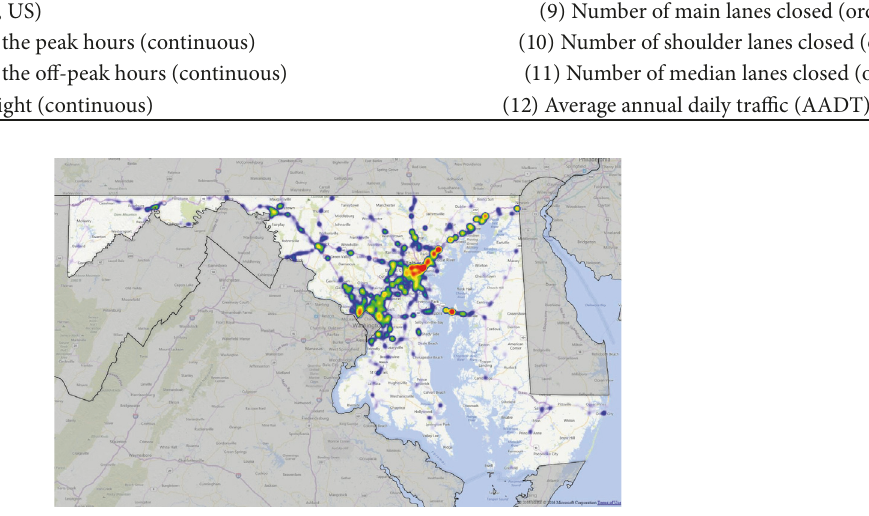
Figure 1: Heat map showing locations of over 54 thousand WZs that took place in Maryland during 2010-2015. The pie chart indicates that majority of WZs were setup along MD and Interstate roads.